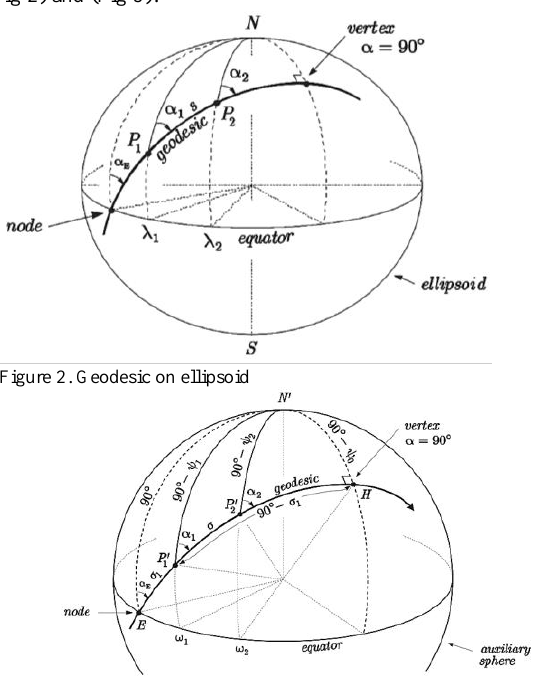
Figure 2. Geodesic on ellipsoid